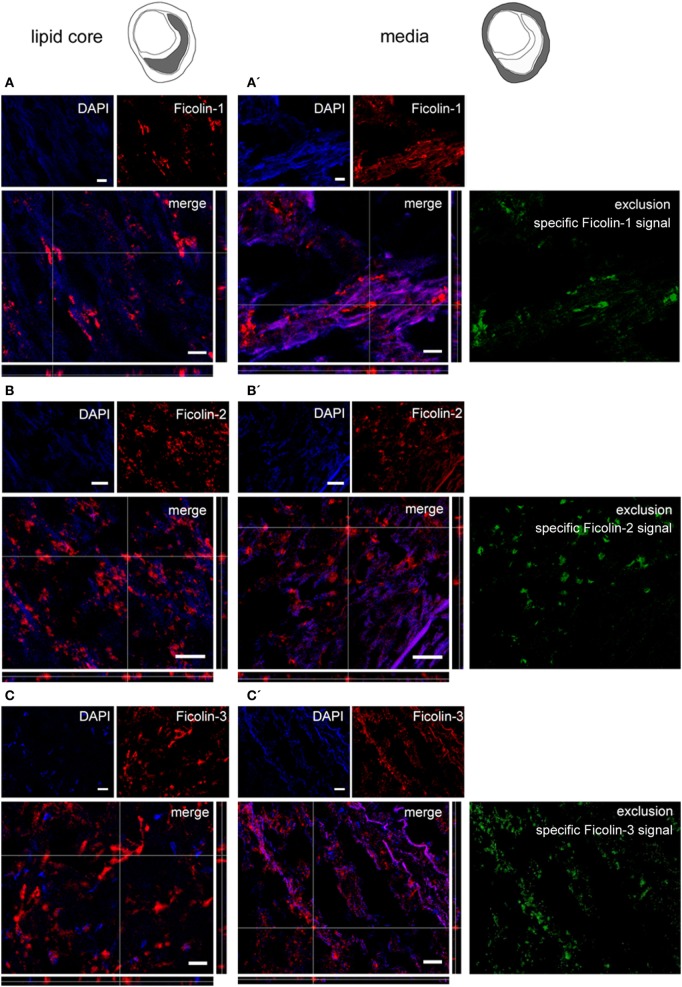
Ficolin 1, 2, and 3 presence in plaques. Microphotograms of the lipid core (left) and tunica media (right). (A,A′) Ficolin-1 (red) was in both lipid core and tunica media. To exclude the collagen non-selective fluorescent signal, we obtained an exclusion image showing only the ficolin-1 specific signal (green) and confirmed ficolin-1 presence in tunica media. (B,B′) Ficolin-2 (red) and (C,C′) Ficolin-3 (red) were also in lipid core and tunica media. Nuclei are blue. Scale bars = 20 μm.